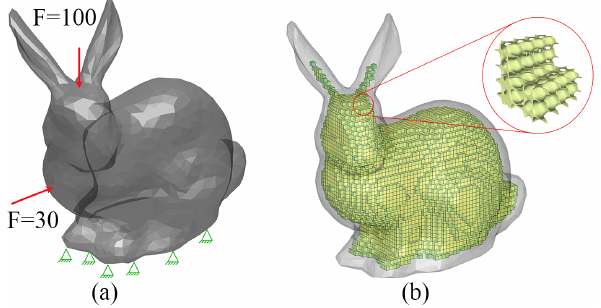
Figure 15. Stanford bunny model: ( a ) boundary condition and loading, ( b ) optimization result using isotropic ( F D ) cellular material.